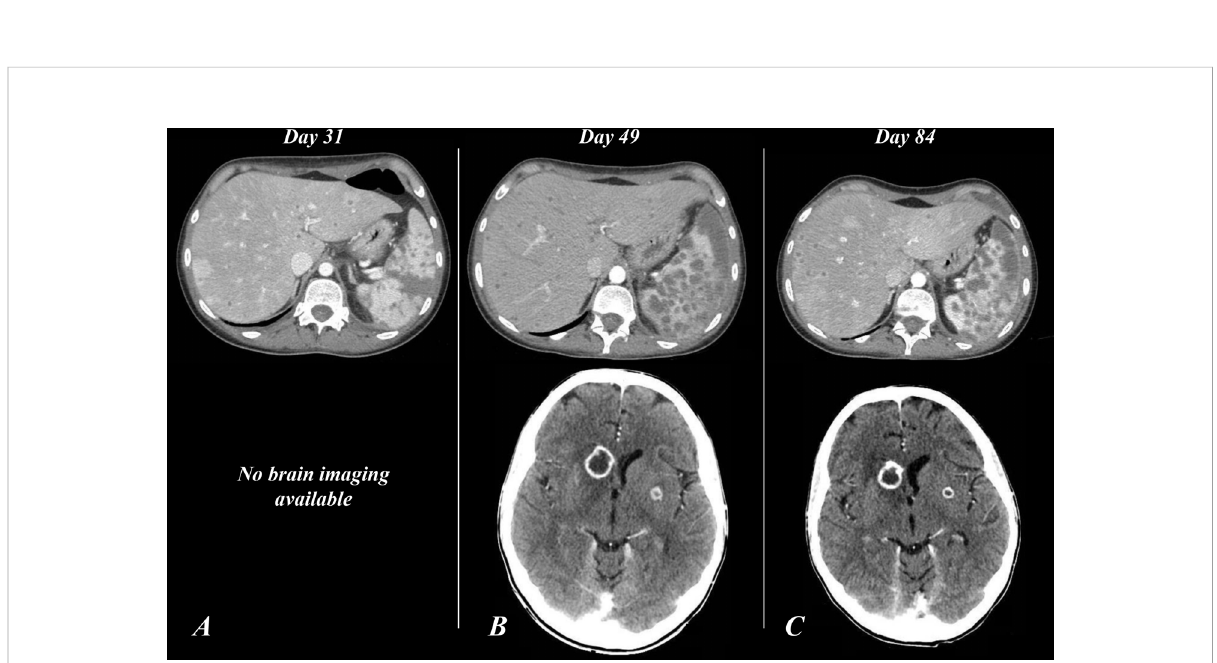
FIGURE 2 Contrast-enhanced CT scan of the abdomen (A – C) and the brain (B, C) . Panel A ( day 31 ), fi nding of multiple, sub-centimetric, hypodense lesions involving the spleen and liver parenchymas. (B) ( Day 49 ), spleen and liver enlargement; increase in number and size of the hypodense round lesions, some with con fl uent and lique fi ed patterns; new fi nding of nodular ring-enhancing lesions of the subcortical CNS with compression of the frontal (anterior) horn of the right lateral ventricle, and involvement of the left-side putamen. (C) ( Day 84 ), con fi rmation of abdominal picture; stable brain lesions, expansion of the lesion surrounding with complete fl attening of the frontal pole of the right lateral ventricle. CT, computed-tomography; CNS, central nervous system.